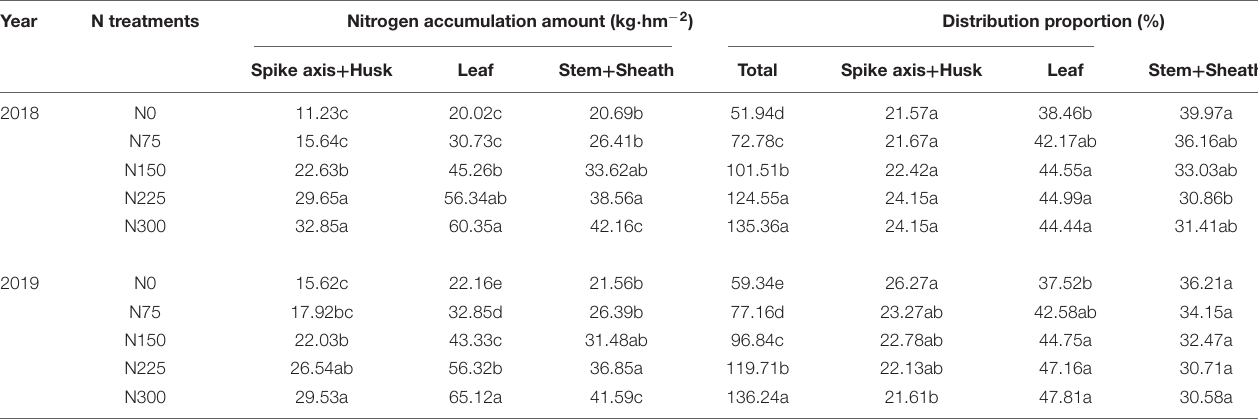
TABLE 3 | Nitrogen accumulation and distribution proportion in different organs at flowering stage of winter wheat in 2018 and 2019 under different nitrogen application rates.